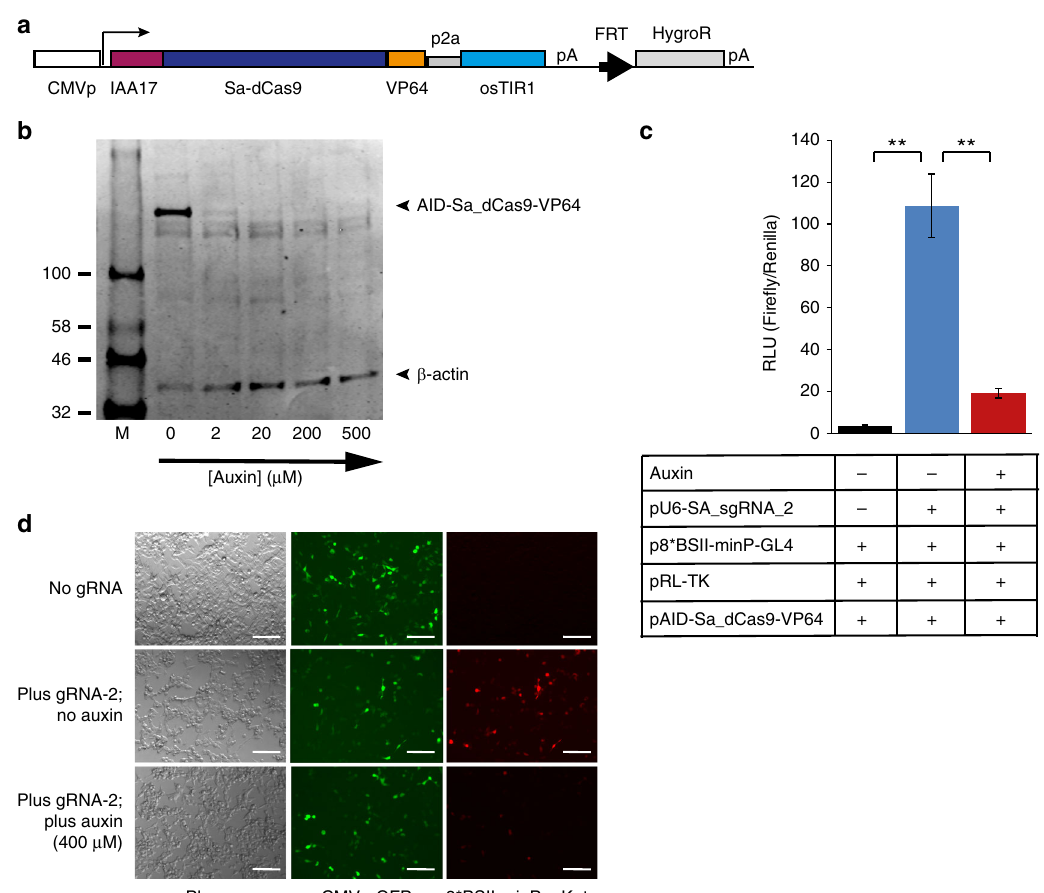
Fig. 4 The AID system functions with stably integrated Staphylococcus aureus dCas9 (Sa-dCas9) fused to the VP64 transactivation domain. a Schematic representation of the AID-Sa-dCas9-VP64 construct. b Western blot of HEK293-Trex-FlpIn cells stably expressing AID-Sa-dCas9-VP64 and treated with increasing concentration of auxin as indicated. c Dual luciferase assay on stably expressing AID-Sa-dCas9-VP64 cells transfected with a luciferase reporter driven from a minimal promoter containing eight binding sites for an S. aureus compatible guideRNA (p8BS-II-minP-GL4), a Renilla luciferase control plasmid containing the ubiquitous Thymidine kinase promoter (pRL-TK) and an S. aureus sgRNA (pU6-Sa_gRNA-2) expression construct. Black column, no sgRNA transfected; Blue column, no auxin added; Red columns, auxin added (400 μ M). Error bars ± s.d. ( n = 3). (**) P < 0.01 two-tailed t -test. d Fluorescent reporter expression is abrogated in the presence of auxin in cells stably expressing AID-Sa-dCas9-VP64. Scale bar, 100 μ m. All samples were transfected with a constitutive GFP expression construct, an mKate construct with a minimal promoter containing eight binding sites for an S. aureus guideRNA target sequence (p8BS-II_minP-mKate), and an S. aureus sgRNA (pU6-Sa_gRNA-2) expression construct (middle and bottom rows only), in the absence (top and middle rows) or presence of auxin (400 μ M; bottom